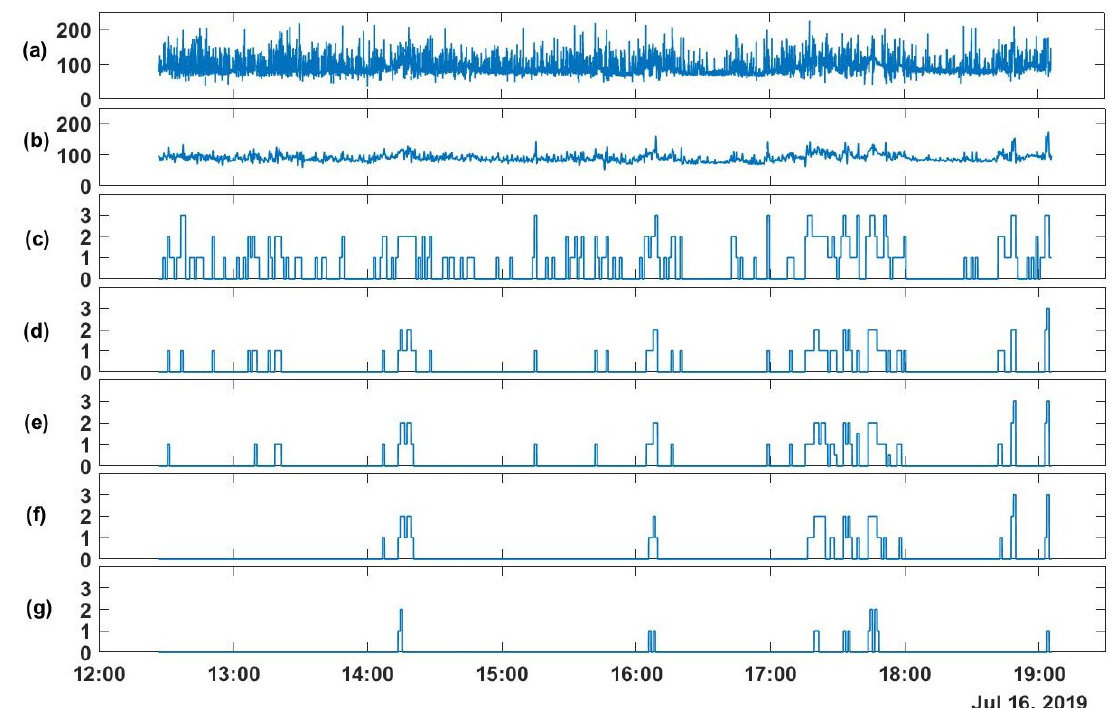
Figure 4. From the heart rate (HR) of a postsurgical patient: ( a ) The raw signal (BPM), ( b ) the denoised signal (BPM), ( c ) the maximum, ( d ) the mean, ( e ) the median, ( f ) the median based on moving median filter, and ( g ) the minimum values of the EWS component of HR for each one-minute